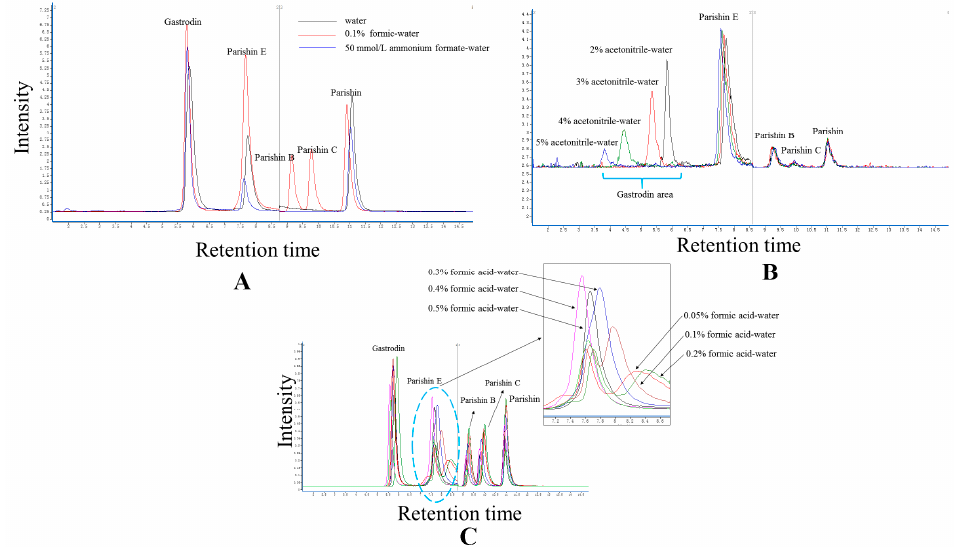
Figure 1. Optimization of elution system. Comparison was presented on the base of total ions mass spectrograms. ( A ) Type of aqueous phase; ( B ) Percentage of initial mobile phase; ( C ) Acidity in aqueous phase.